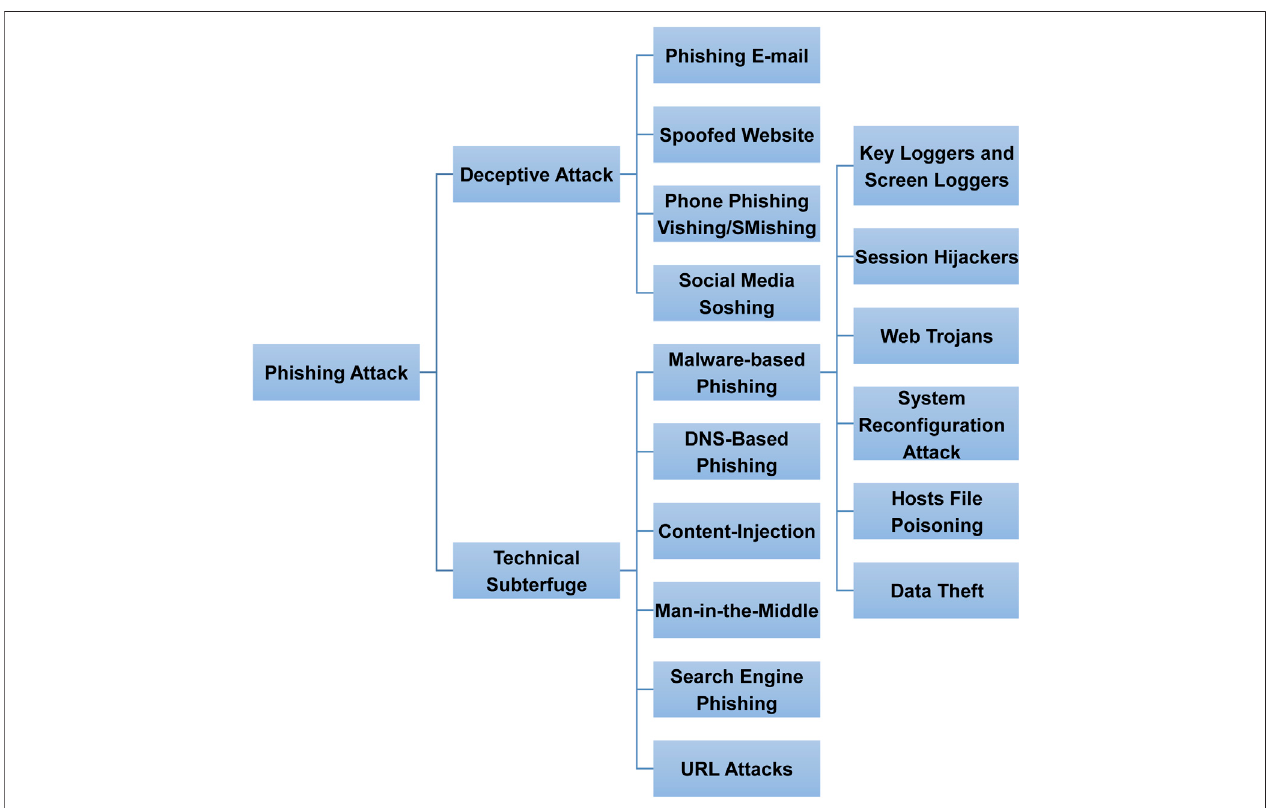
FIGURE 9 | Phishing attack types and techniques drawing upon existing phishing